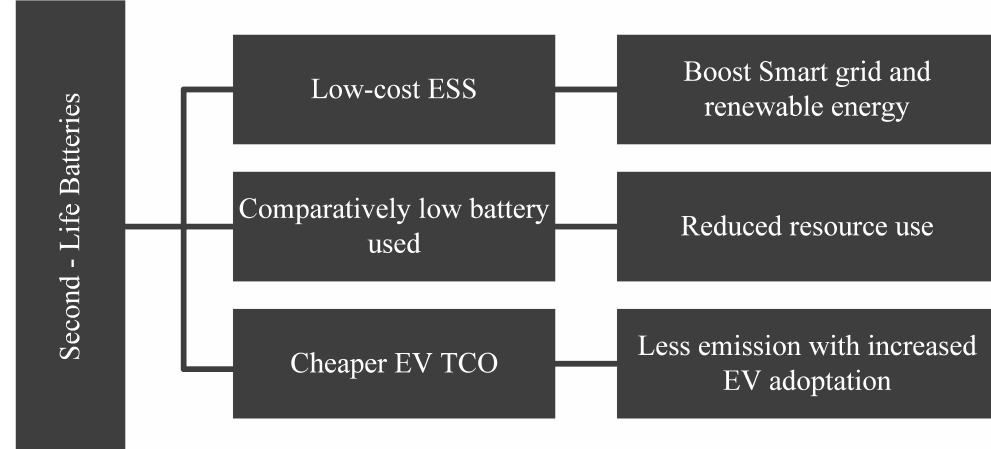
Figure 7. Advantages of second-life batteries used in stationary storage applications.